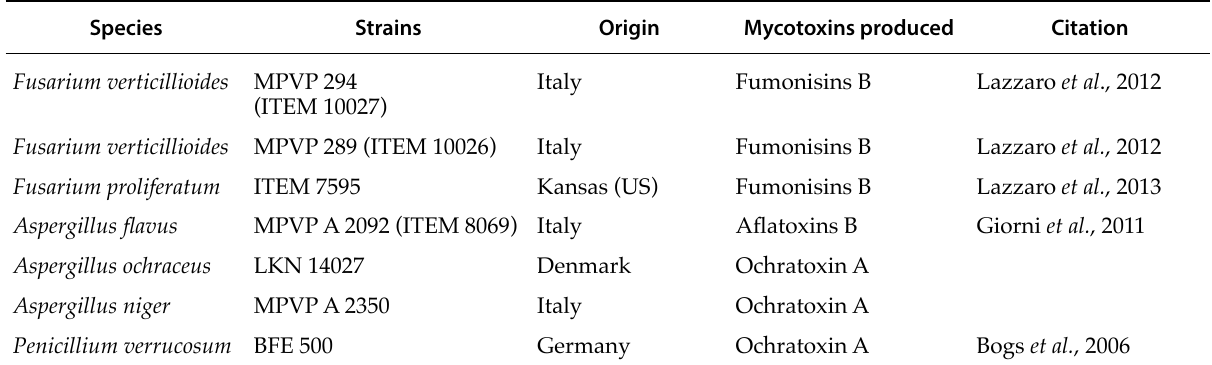
Table 1. List of fungal strains used in this study, their codes in fungal collections, mycotoxin produced and papers where they were previously described or